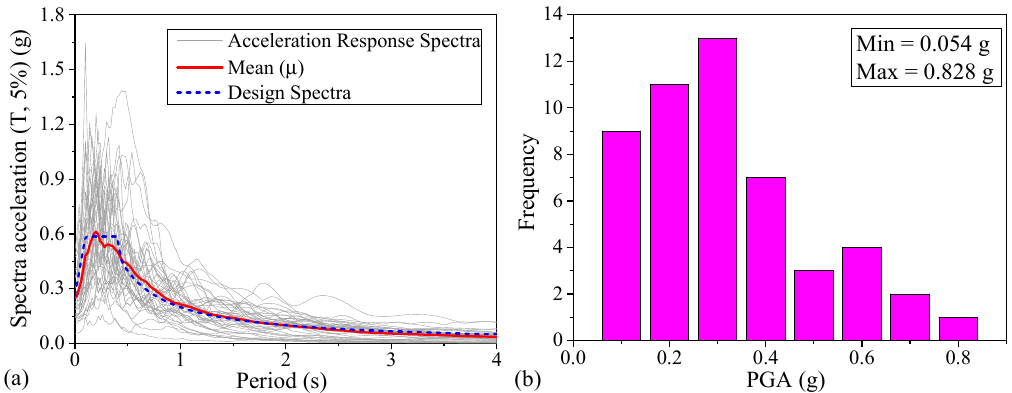
Figure 9. Acceleration spectra and PGA distribution of the selected ground motions: ( a ) acceleration spectra and ( b ) distribution of the PGA values.